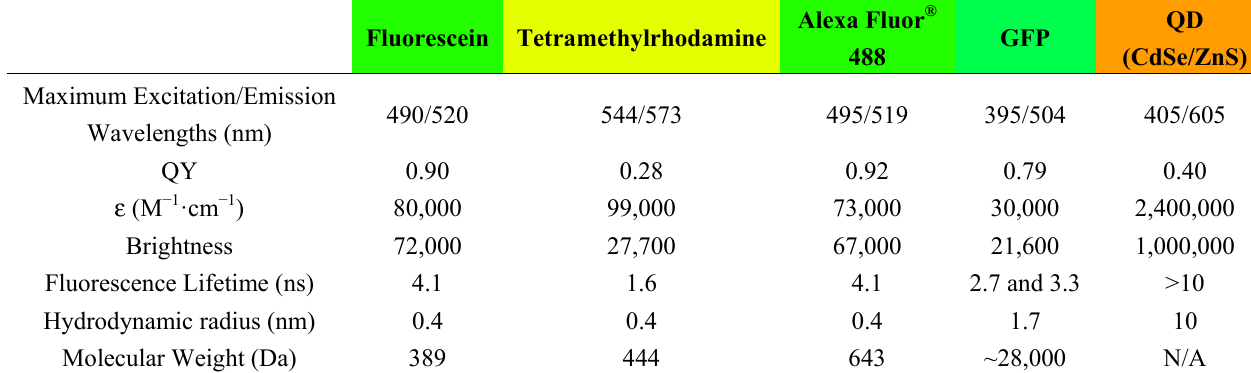
Table 1. Properties of the principal fluorophores used for PCW